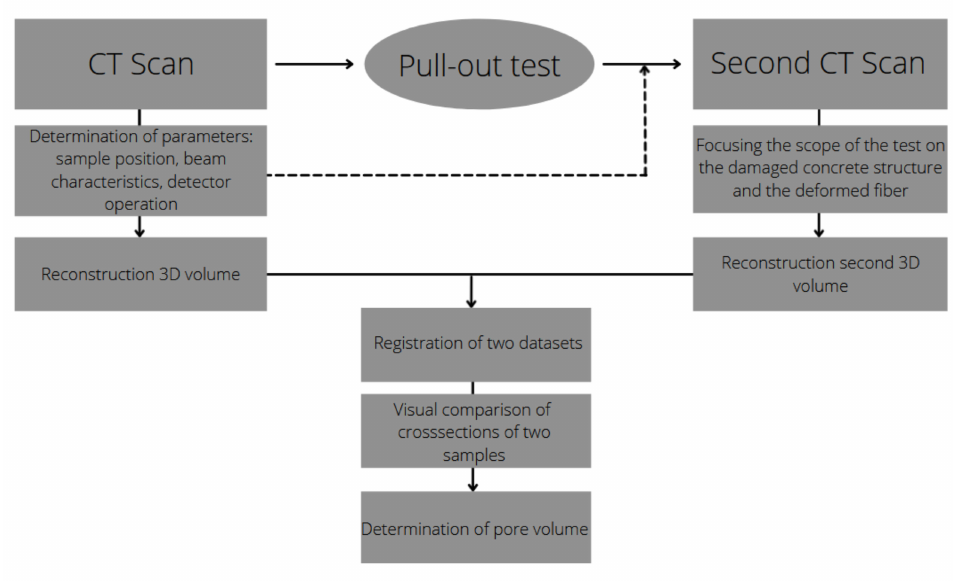
Figure 4. Data workflow